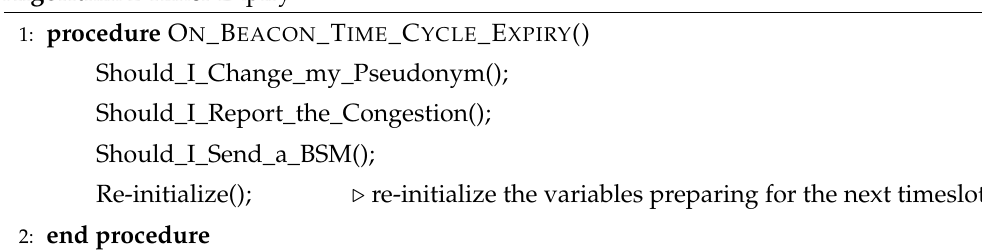
Algorithm 2 Timer